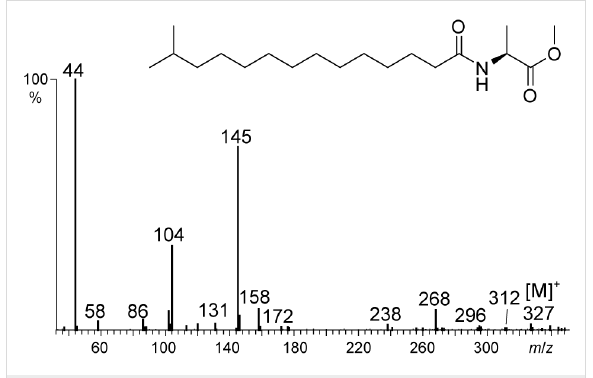
Figure 3: Mass spectrum of natural compound D , N -(13-methyltetra- decanoyl)alanine methyl ester ( iso -C15:0-NAME, 6